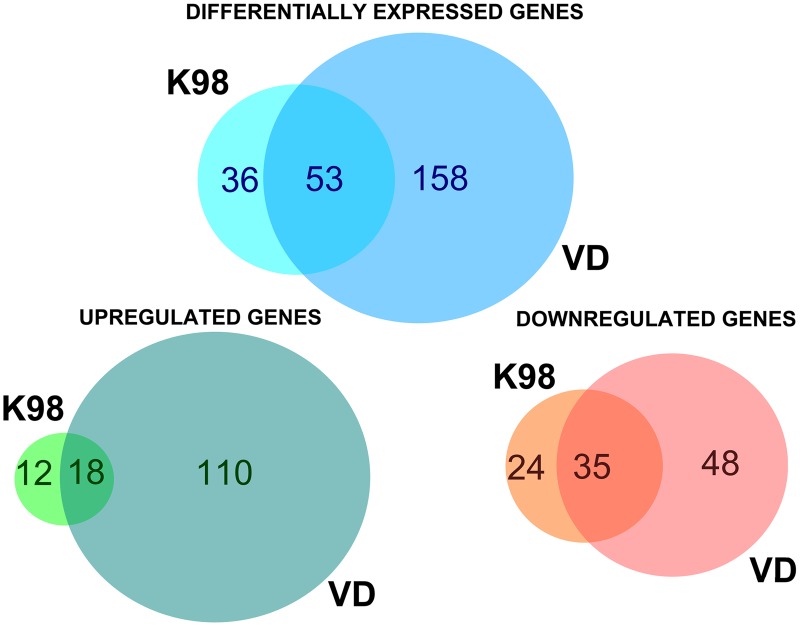
Venn diagrams analysis.Numbers embedded in each complete circle denote the total numbers of DEGs of the indicated infected groups in comparison to the uninfected control group; those in the overlapping region depict the number of shared genes between the two conditions.